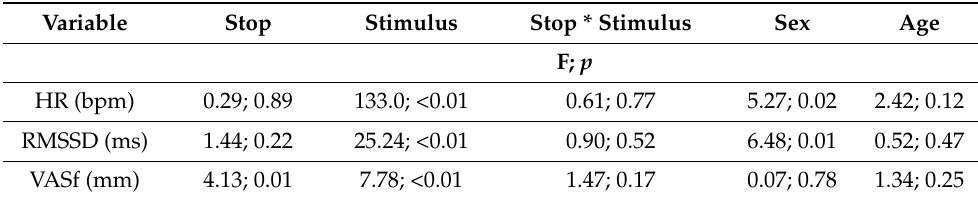
Table 4. Statistical significance of Stop, Stimulus, the interaction of Stop and Stimulus (Stop * Stimulus), Sex and Age for HR, RMSSD and